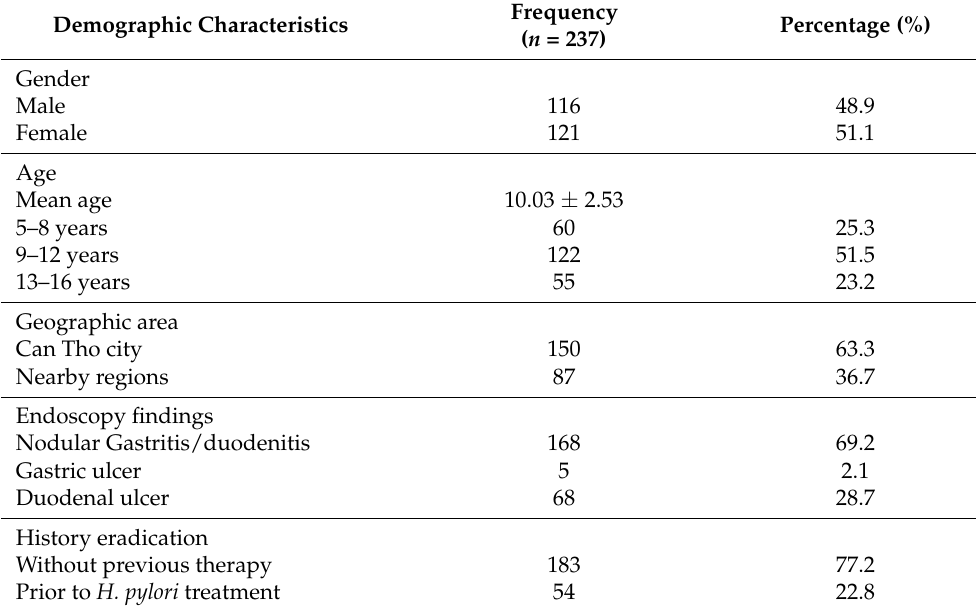
Table 1. Patient characteristics.